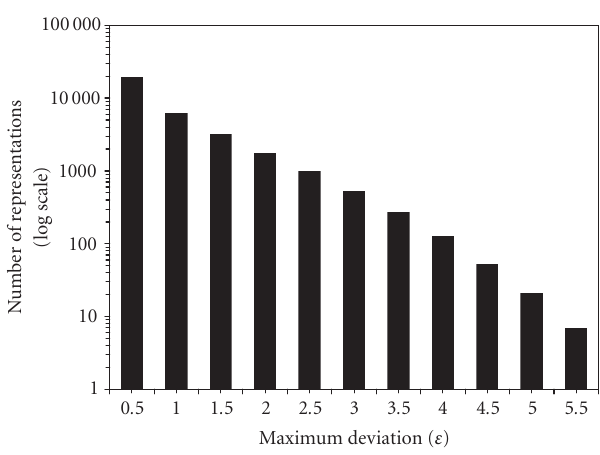
Figure 12: Histogram of error in data optimized high/low 2DLNS input mapping.